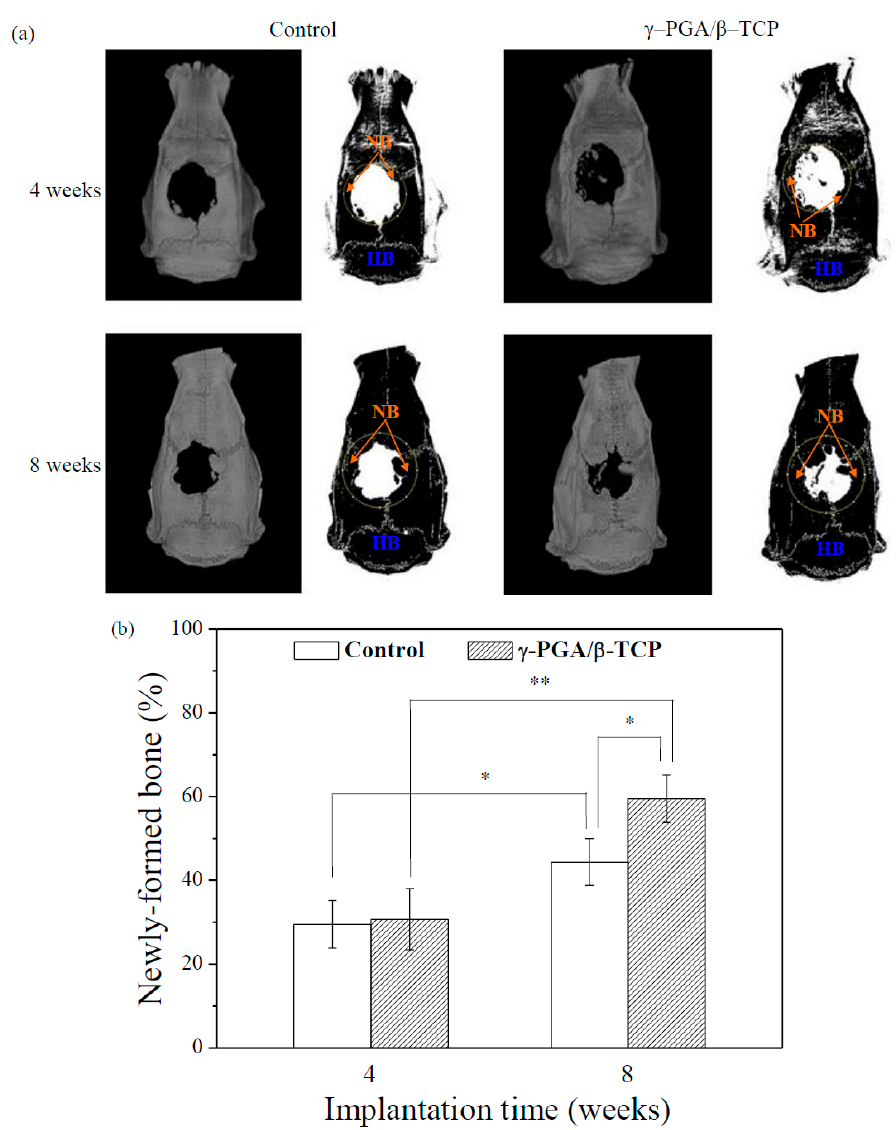
Figure 7. ( a ) Micro-CT images of the rat calvarial bones covered with or without γ –PGA/ β –TCP composite fibrous mats obtained 4 and 8 weeks postimplantation (HB = host bone, NB = new bone). The dotted circles indicate the original defects. ( b ) The quantitative micro-CT analysis of the newly formed bones in the rat calvaria defects (* p < 0.05 and ** p < 0.01).